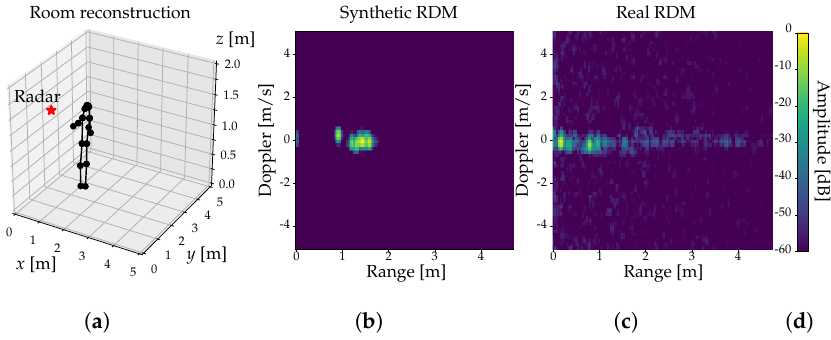
Figure 3. Radar data synthesis ( a ) CV-generated skeleton keypoints. ( b ) Synthetic radar data. ( c ) Real radar data. ( d ) Color bar.